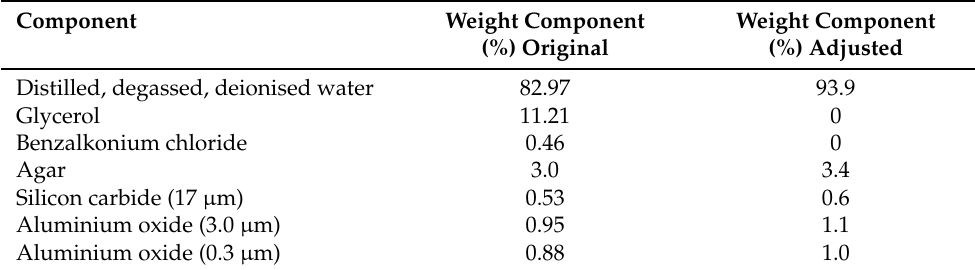
Table 2. Weight composition of the IEC TMM (in % per weight) according to [16] (left) and the adjusted composition (right), which we used in the course of our research, dividing the proportions of glycerol and benzalkonium among the rest